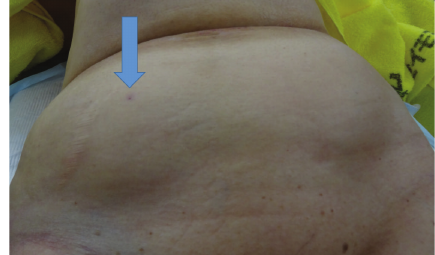
Figure 1: The right lower abdomen, showing a distended right lower quadrant with a central injection site (arrow).